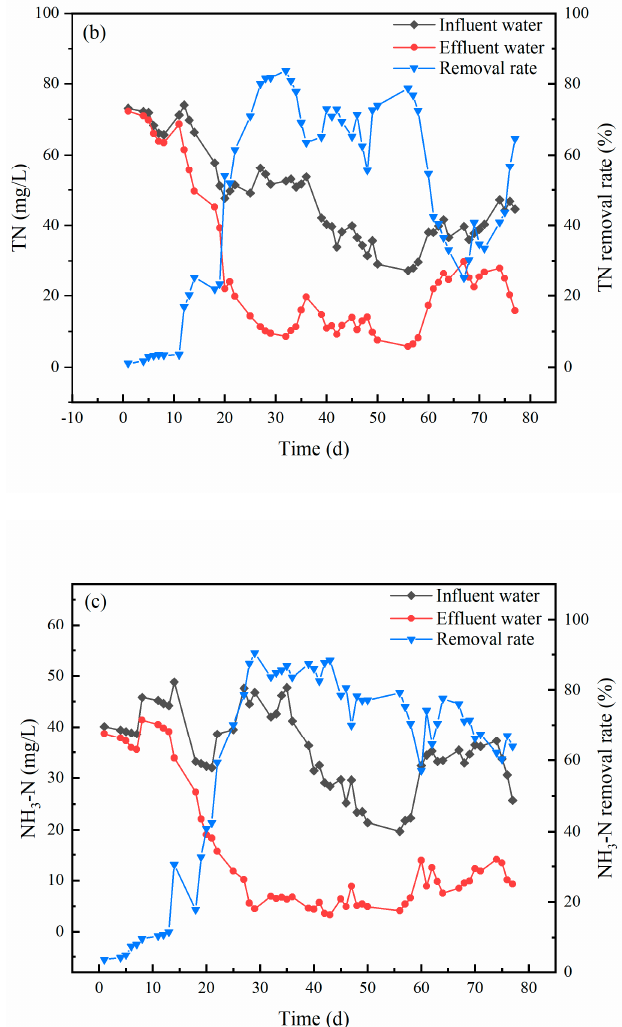
Figure 4. Effect of running time on processing efficiency of the first-level AO unit: ( a ) COD, ( b ) TN, and ( c ) NH 3 -N.